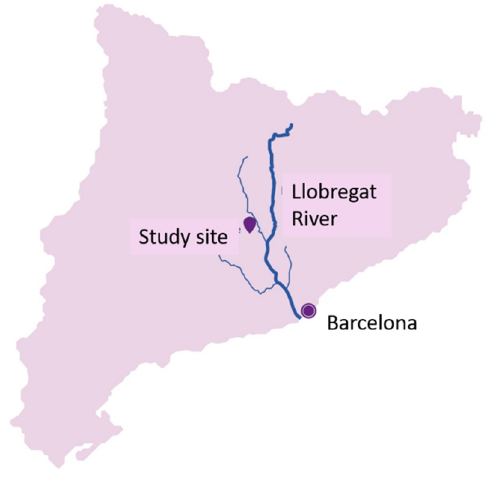
Figure 1. Study site location, a network in Catalonia supplied by the Llobregat River.